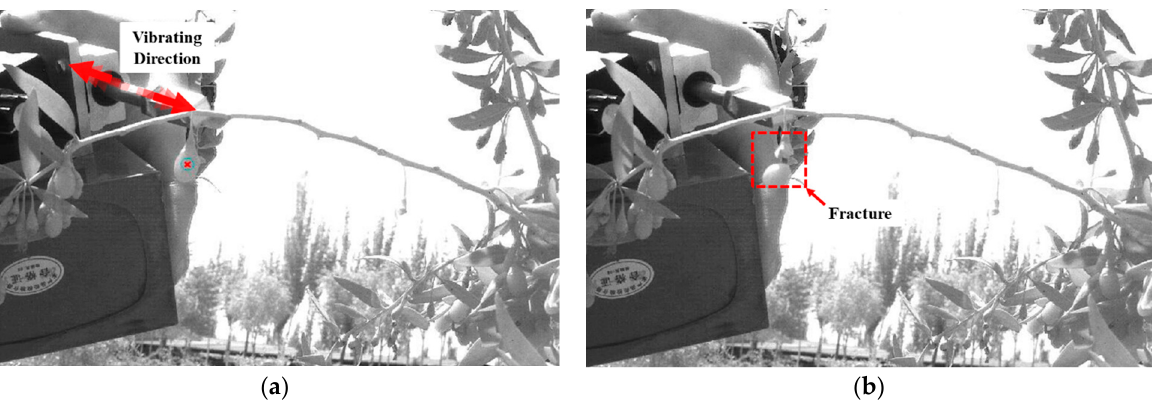
Figure 7. The process before the vibration ( a ) and under the vibration ( b ) recorded by the high-speed camera.